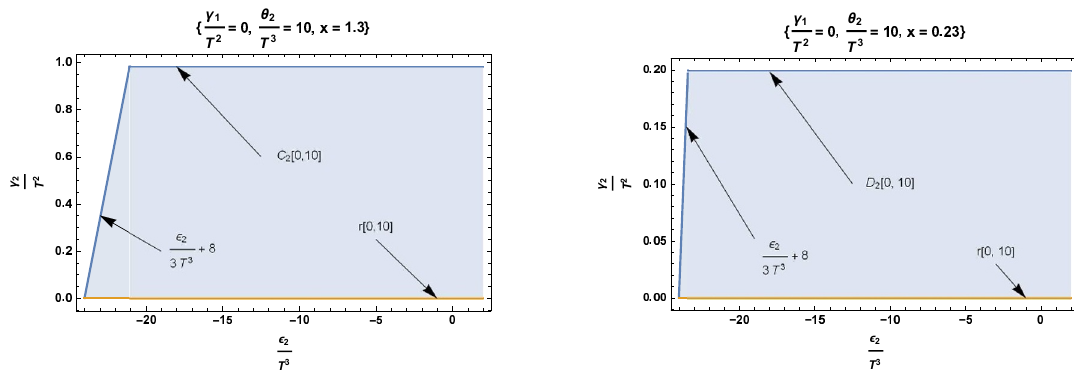
Figure 8 . Acceptable zones in the case of finite µ 0 and T 0 . Boundaries are given in terms of table 1 data. The left and right figure has area of 24.04 and 5.11, respectively.